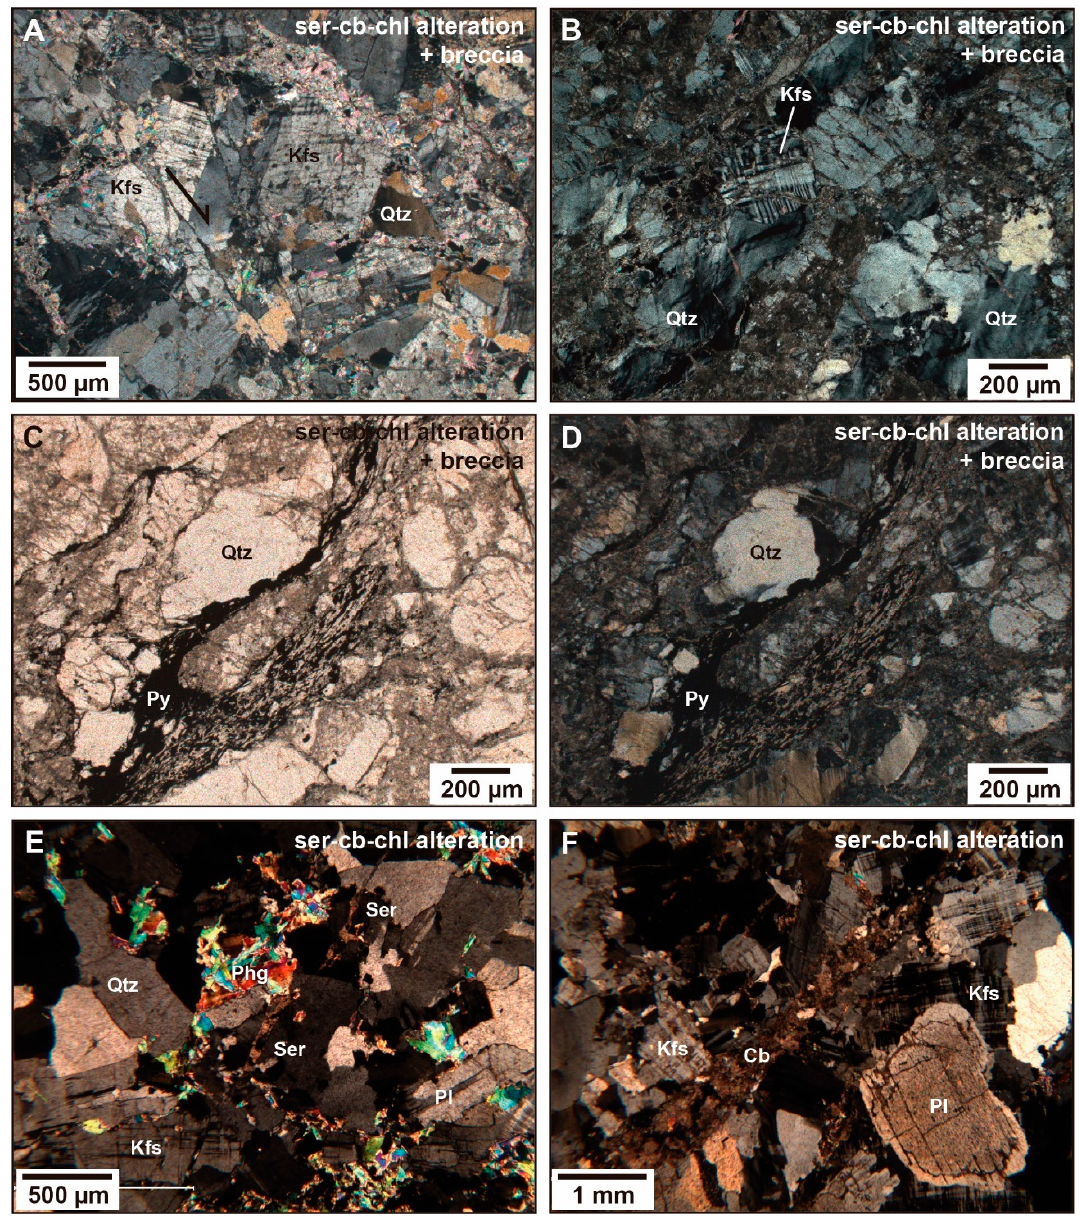
Figure 10. Microscopic aspects of the SCC alteration in the Passa Três deposit: ( A ) to ( D ) SCC alteration superimposed and/or forming breccia (red granite) at the border of the orebody with some evidence of normal faulting ( A ), fractured K-feldspar crystal ( B ) and formation of pyrite-rich levels ( C , D ); ( E ) SCC alteration with sericite planes affecting the texture of the granite; ( F ) Carbonate planes associated to the SCC alteration. Images ( A – F ) optical microscope—natural ( C ) and polarised